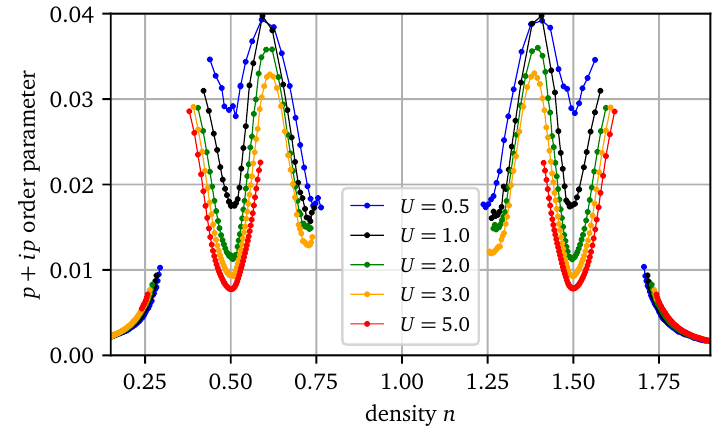
Figure 4: p + ip order parameter found by CDMFT, as a function of electron density n , for several values of Hubbard U (in meV). The order parameter is the ground state average of the operator (2e), restricted to the cluster. The density n is the ground- state average occupation of the cluster. One of the clusters of the first layer was used for these averages. Clusters on the second layer would show the opposite chirality ( p − ip